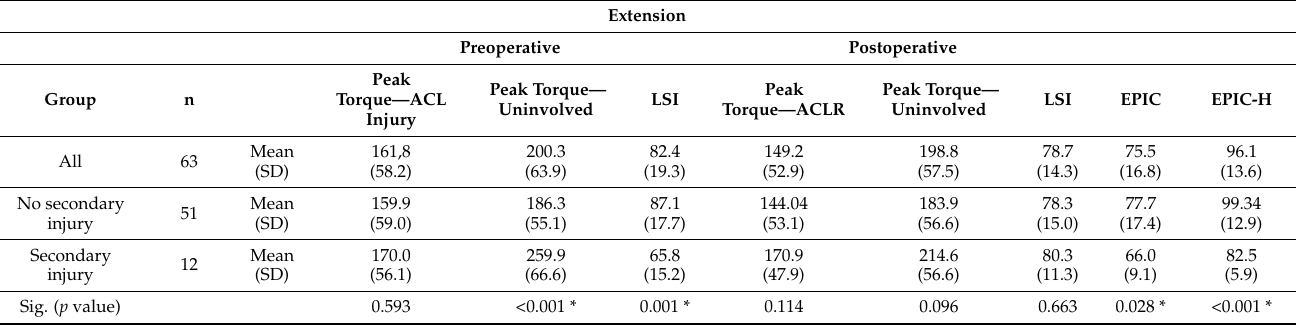
Table 2. Mean peak torque (Nm) values for knee extension, LSI, and comparison between groups with secondary ACL injury and without secondary injury.